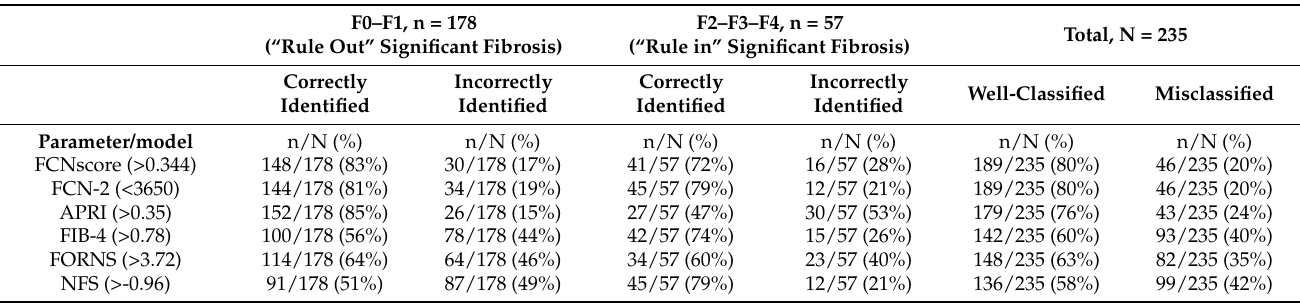
Table 5. Classification of subjects in the combined cohort according to moderate/advanced fibrosis (prevalence 25%, n =